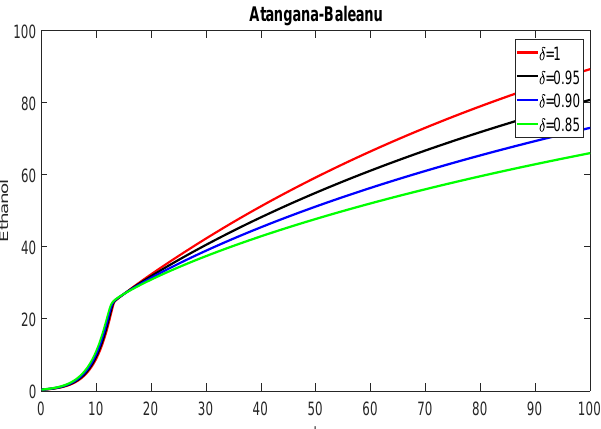
Figure 6. Evolution of the substrate, biomass, and ethanol for fractal dimension 0.9 and different fractional orders in Atangana–Baleanu sense.